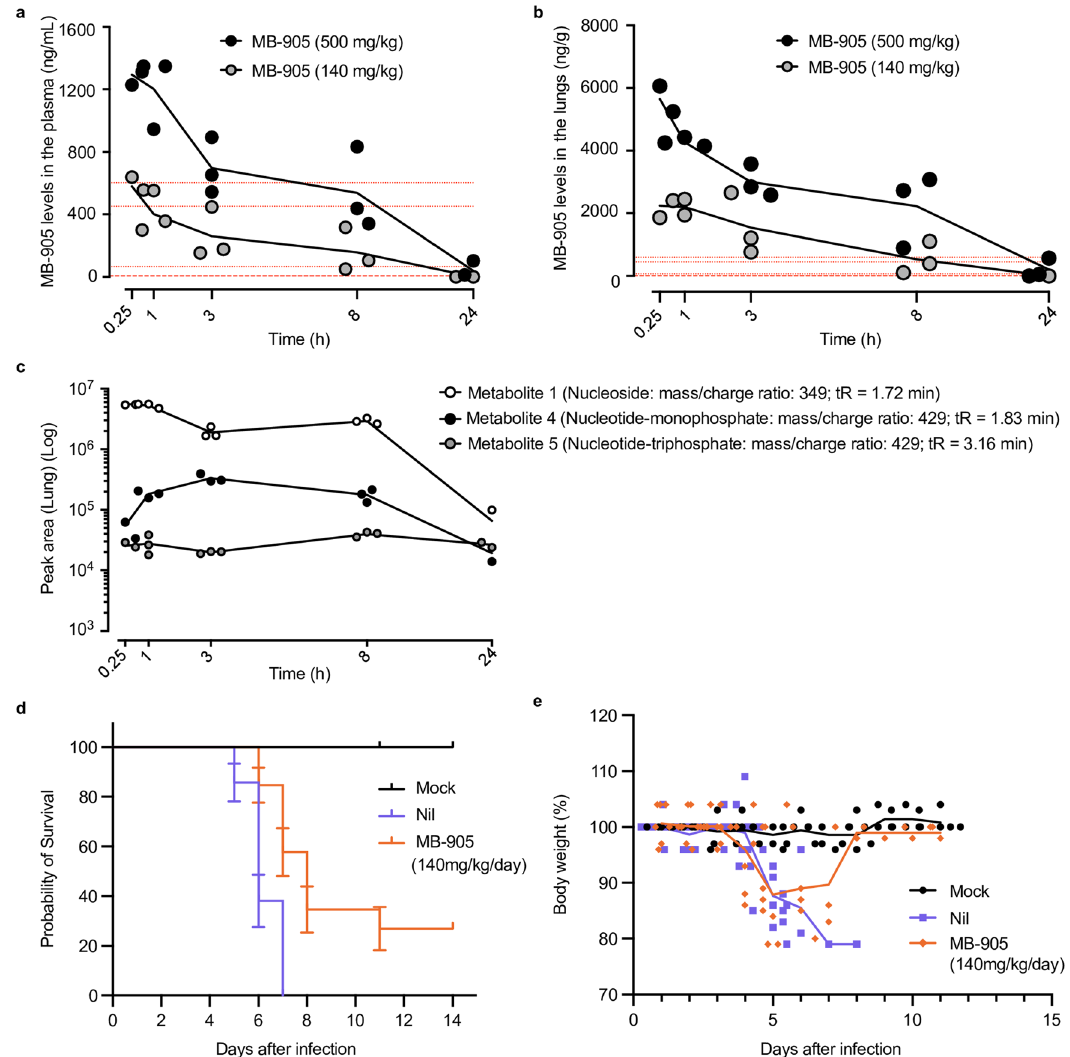
Fig. 5 | Pharmacokinetic and pharmacodynamics in mice. Single oral treatment of MB-905 in mouse plasma ( n =6) ( a ) and lungs ( n =6) ( b ), dotted red lines representthevaluesofEC 50 andEC 90 forMB-905whenaddedonceortwicetocalu- 3-infected cells.Lung metabolitesweredetected consistently in terms of peakarea and duration ( c ). Transgenic mice expressing the hACE2 receptor to